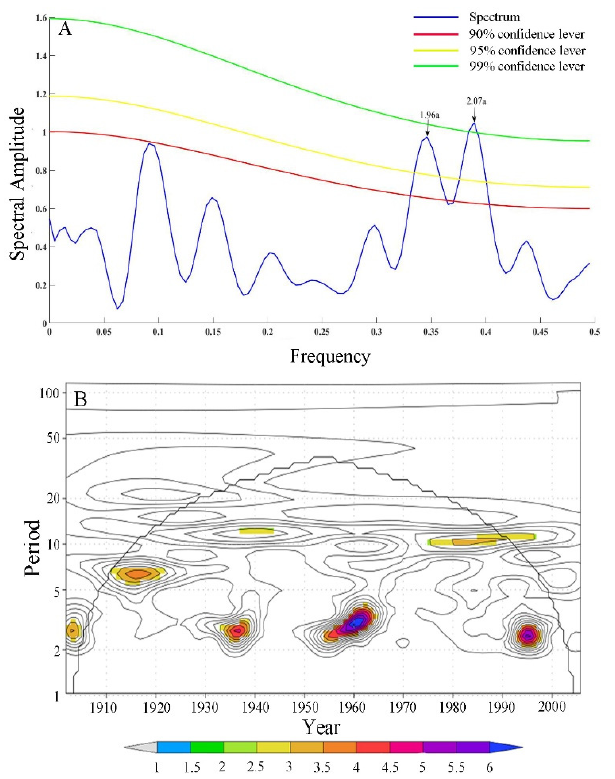
Figure 11. The periodic variation of the reconstructed T MJ series from 1901 to 2005 in the Tongbai Mountains using the power spectrum analysis ( A ) and wavelet analysis ( B ); 2.07a and 1.96a ( A ) are significant cycles of the reconstructed T MJ from 1901 to 2005 in the Tongbai Mountains, which reach 99% and 95% confidence levels, respectively.